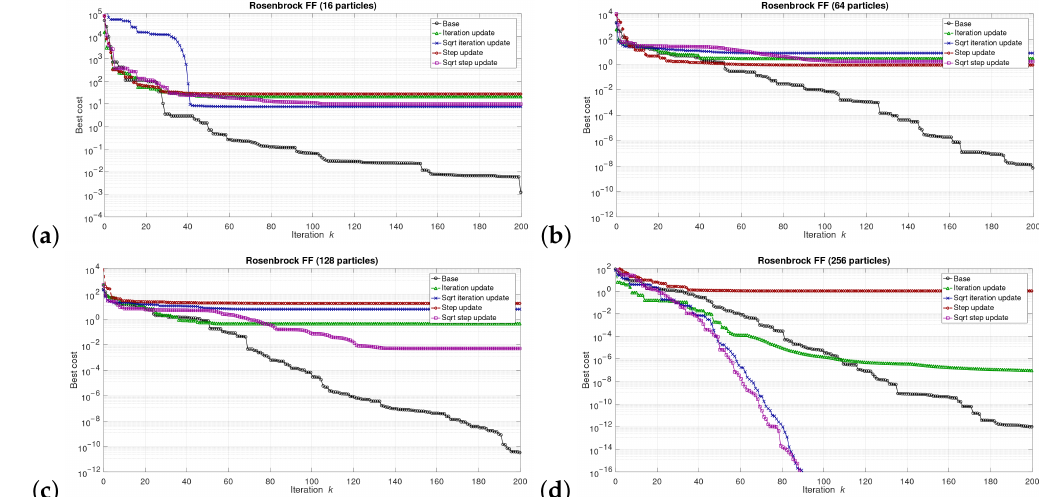
Figure 8. Selected results for Rosenbrock FF for ( a ) 16, ( b ) 64, ( c ) 128, and ( d ) 256 particles.